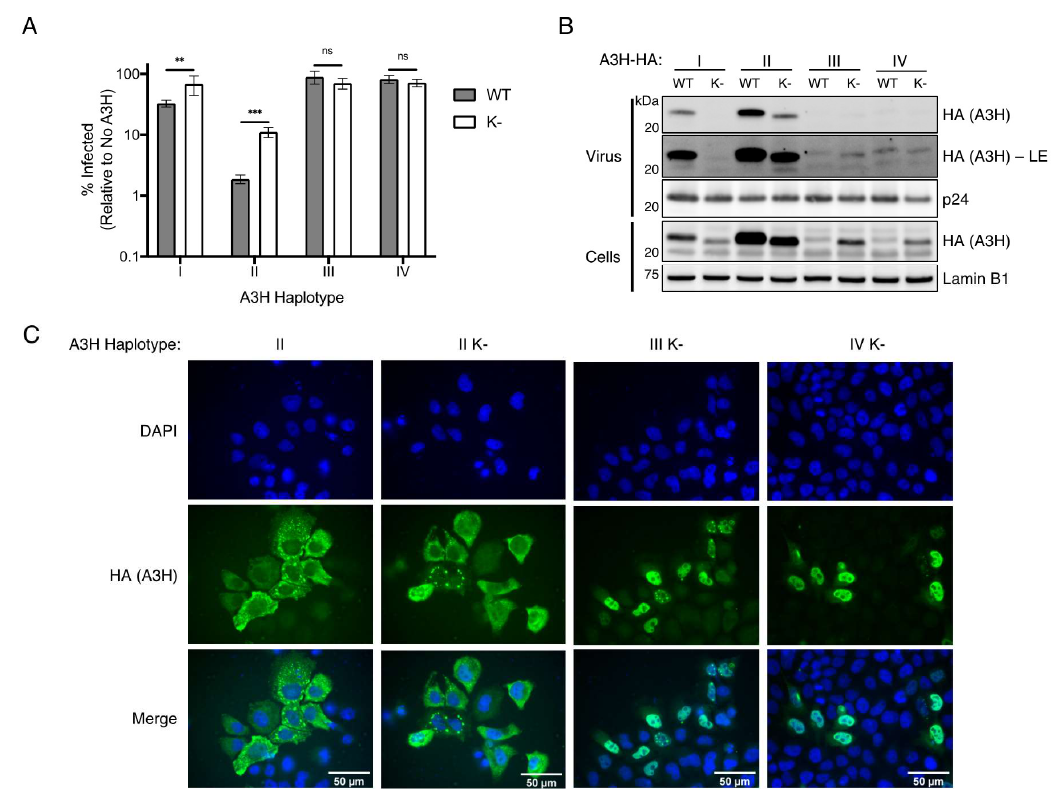
Figure 3. Functional deficiency of A3H haplotypes III and IV is independent of instability. ( A ) Single- cycle viral infectivity assays performed with vif -deficient Human Immunodeficiency Virus-1 (HIV-1) virus produced in the presence of wild-type (WT, gray bars) A3H haplotypes, or lysine-less (K-, open bars) counterparts. Shown is the average of six biological replicates with error bars representing the standard deviation of the mean. ** p < 0.01, *** p < 0.001, ns = not significant ( p > 0.05), unpaired t test. ( B ) Immunoblot of viral supernatant (Virus, top) and whole cell lysate (Cells, bottom) of virus producing cells as in ( A ) using anti-HA to assess A3H levels packaged in virus or expressed in cells. Anti-p24 and anti-Lamin B1 were used as loading controls for virus and cell lysate, respectively. LE = long exposure. ( C ) Immunofluorescence imaging of HeLa cells transfected with wild-type A3H-HA haplotype II or lysine-less A3H-HA haplotype II (II K-), III (III K-), and IV (IV K-). Cells were stained for fluorescence microscopy using anti-HA to detect A3H (green), and DAPI to detect the nucleus (blue). Images are representative of 30 randomly selected field images across three independent experiments.